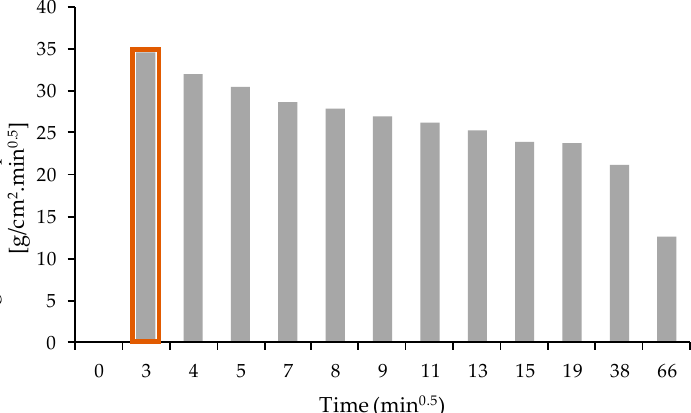
Figure 12. Total water absorption results.